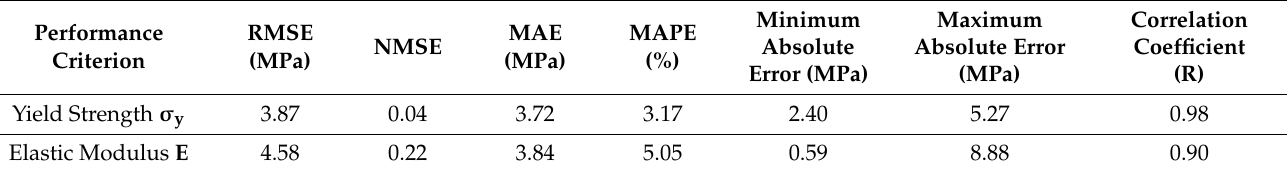
Table 3. Performance of model’s prediction compared to experimental